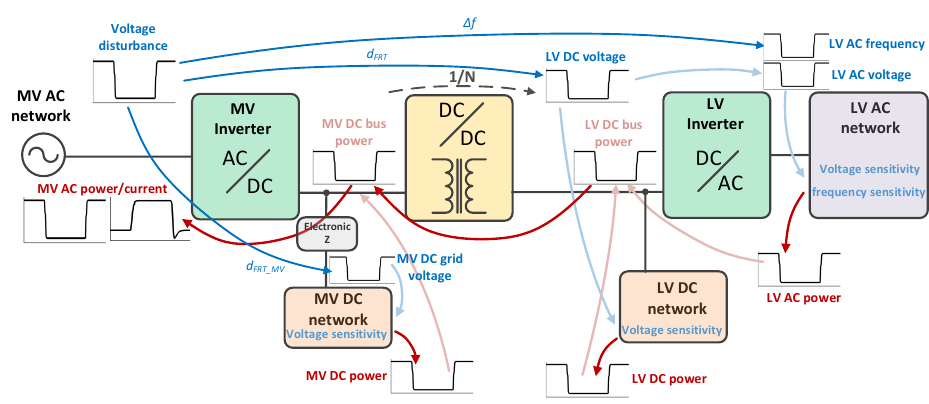
Figure 13. Overview of the cascading effects resulting from the proposed FRT control strategy during a net load scenario in the ST’s hybrid AC/DC grid, following a voltage sag in the MV AC network.